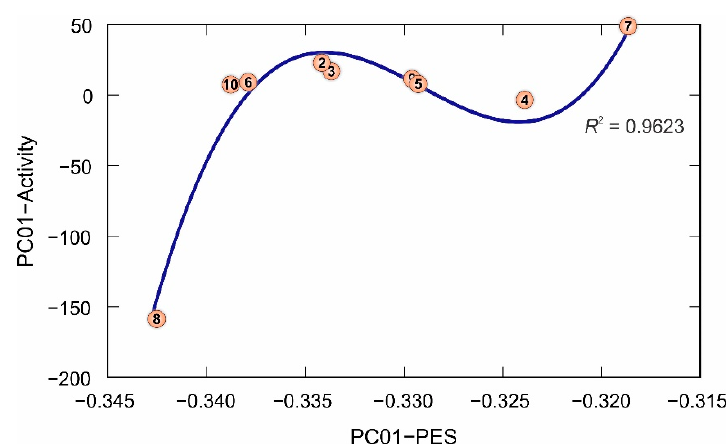
Figure 7. Multivariate regression model of the first principal component of biological activity in dependence on the first principal component of potential energy surfaces.